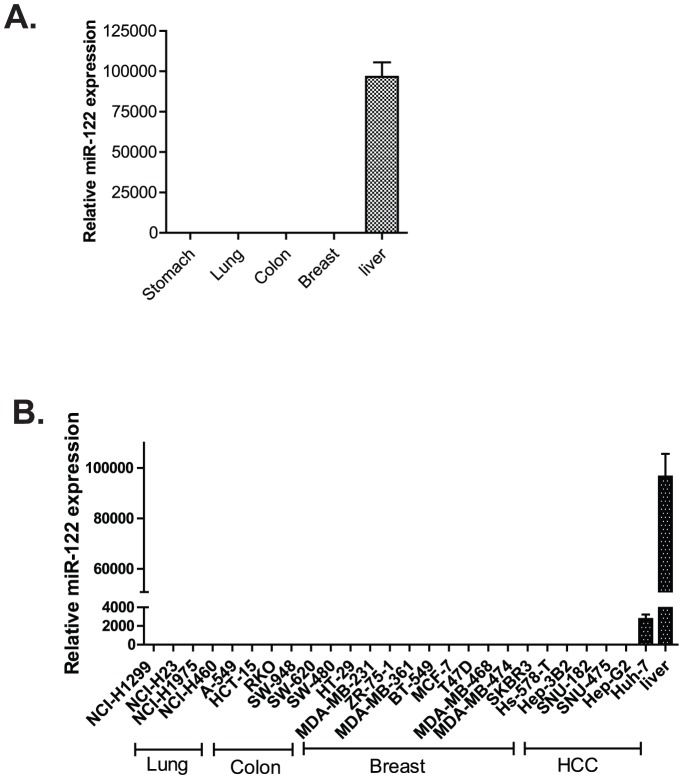
miR-122 is down regulated in human hepatocellular carcinoma cell lines.(A) miR-122 level, normalized to RNU-48, was measured in RNA samples collected from normal stomach, lung, colon, and breast tissues. (B) Normalized miR-122 expression in a variety of human cancer cell lines.